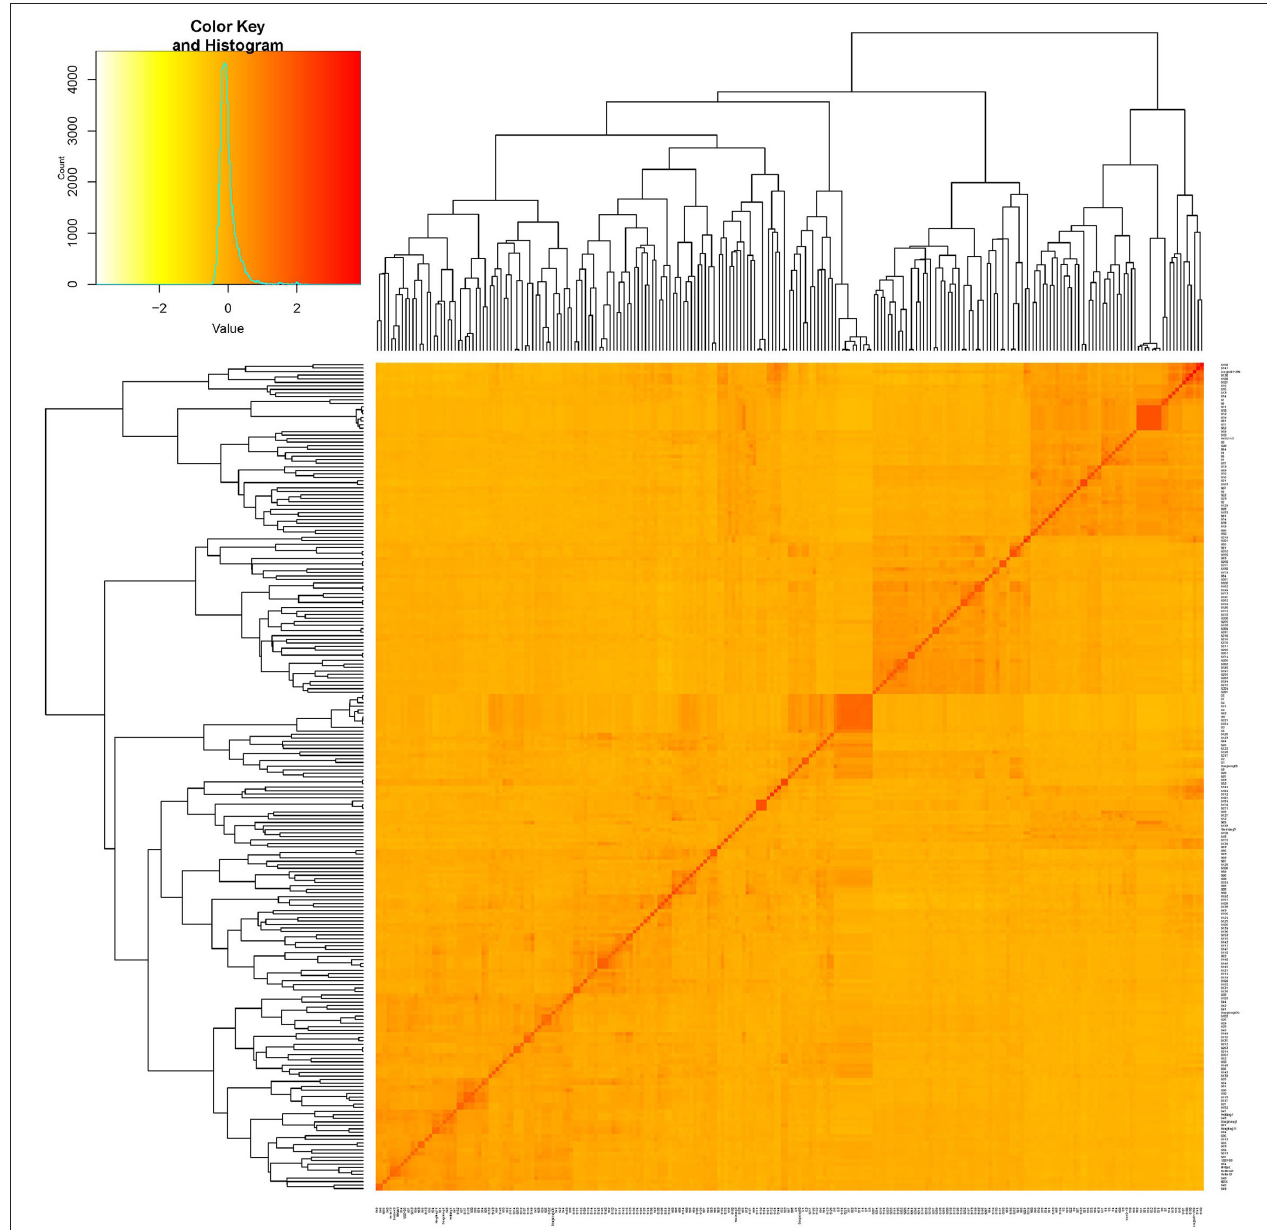
FIGURE 2 | Kinship plot of 235 cultivars. The heat map of the values in the values in the kinship matrix was created using GAPIT (version 2).